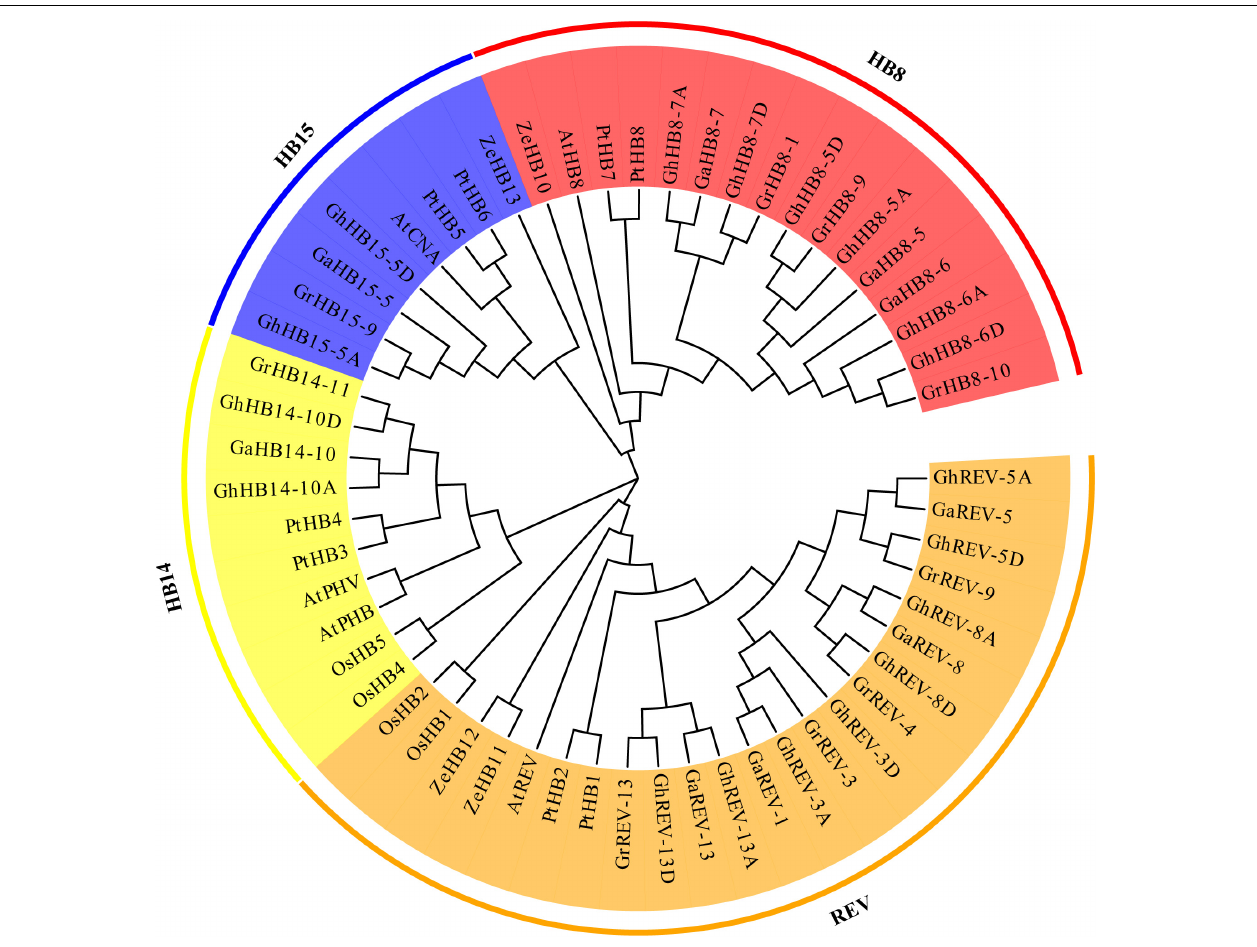
FIGURE 4 | Phylogenetic tree of Arabidopsis , Gossypium arboretum , Gossypium hirsutum , Gossypium raimondii , Oryza Sativa , Populus trichocarpa, and Zinnia elegans HD-ZIP III proteins. All the protein sequences were aligned by ClustalX and the phylogenetic tree was constructed by MEGA7 using the maximum likelihood method with 1000 bootstrap replications. The four groups are represented with different